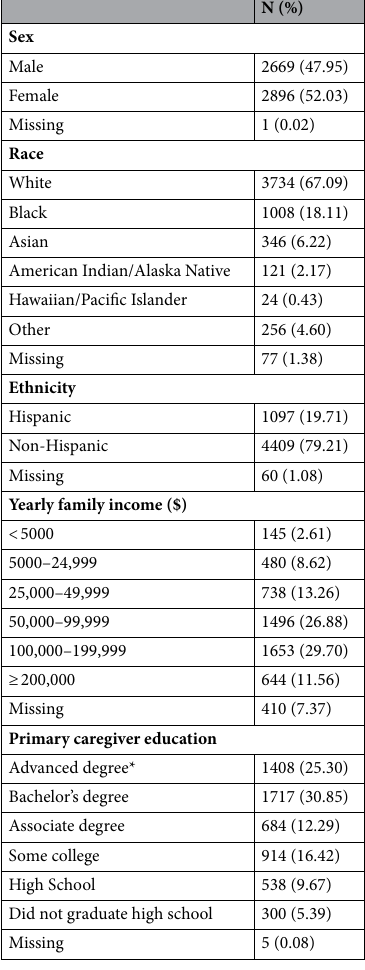
Table 1. Youth/family demographics. *Includes master’s professional (MD, JD, etc.) and doctoral degrees.